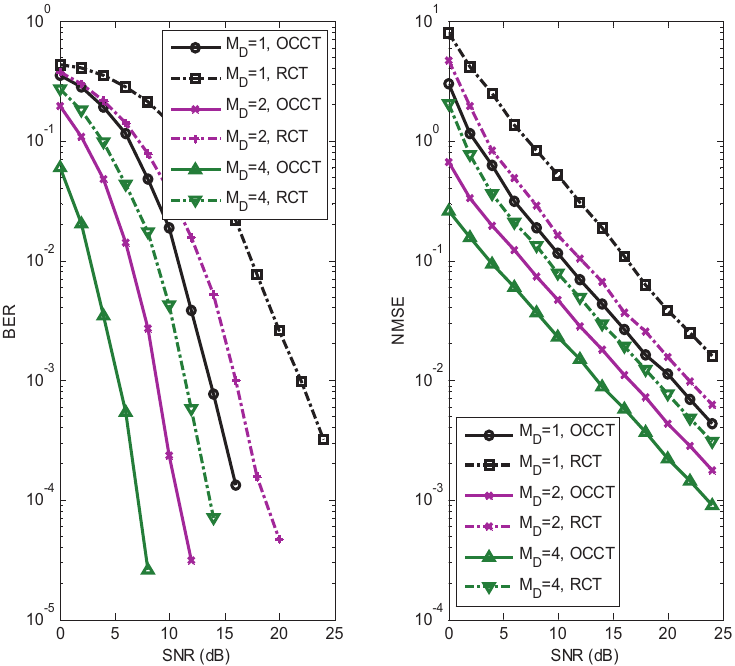
Figure 8. Influence of the receive antenna and the coding